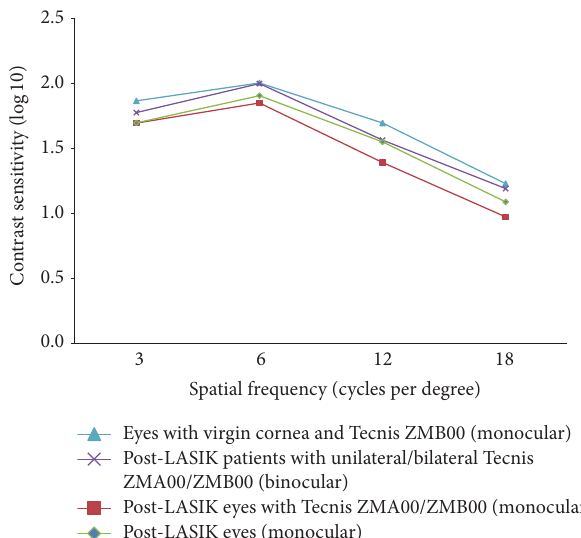
Figure 5: Contrast sensitivity at different spatial frequencies for postlaser in situ keratomileusis (LASIK) eyes with Tecnis ZMA00/ ZMB00 implantation at the last visit (monocular) ( squares ), post- LASIK eyes at the last visit (monocular) ( diamonds ), post-LASIK patients with unilateral/bilateral Tecnis ZMA00/ZMB00 implanta- tion at the last visit (binocular) ( crosses ), and eyes with virgin cornea and Tecnis ZMB00 implantation (monocular) ( triangles ); data from Chang et al.